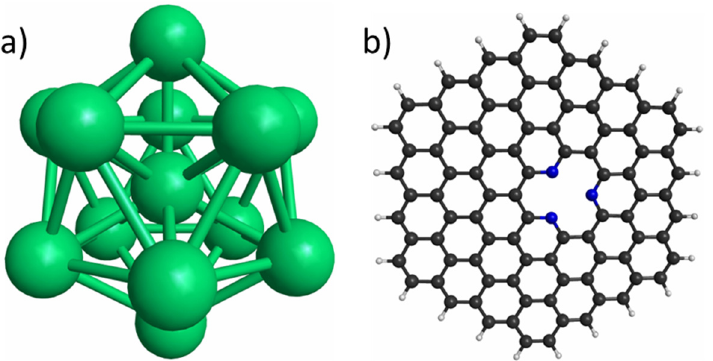
Figure 1. ( a ) Icosahedral metal nanoclusters with 13 atoms; ( b ) Pyridinic N 3 -doped graphene. Green, black, white, and blue spheres represent metal (Co or Cu), C, H, and N atoms,